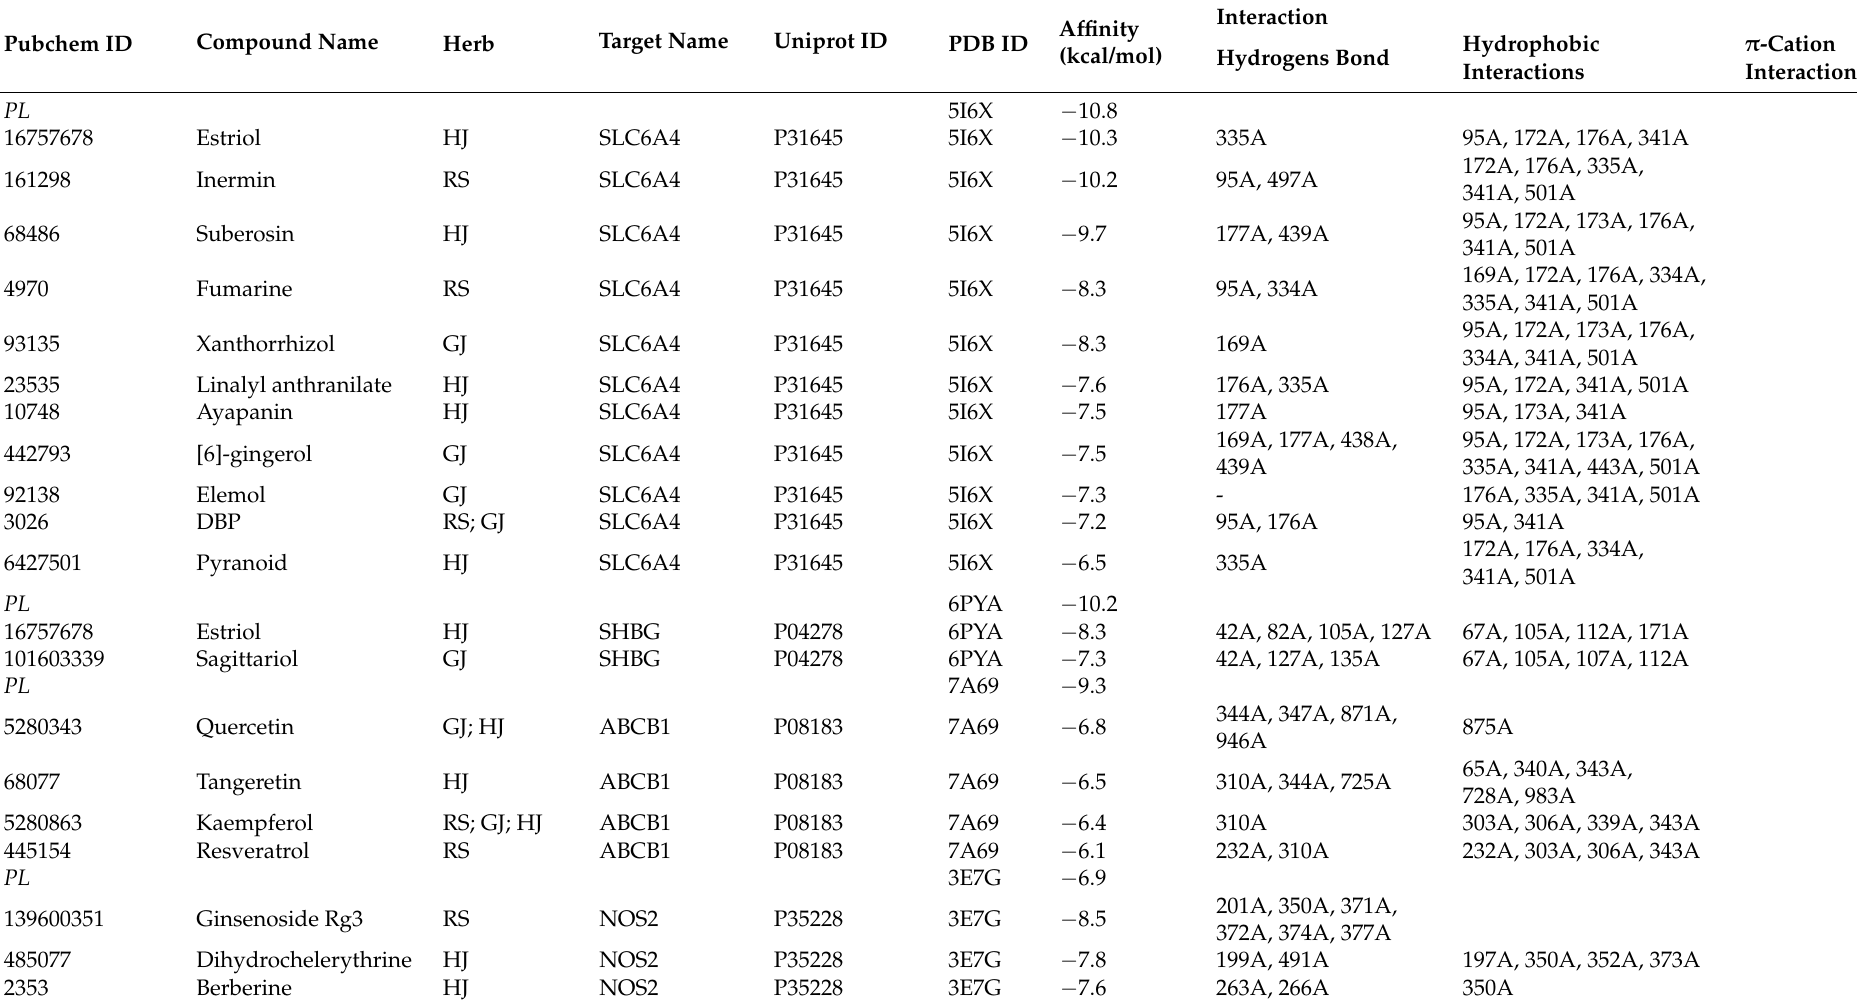
Table 2. Docking results of hub genes and compounds from Dajianzhong